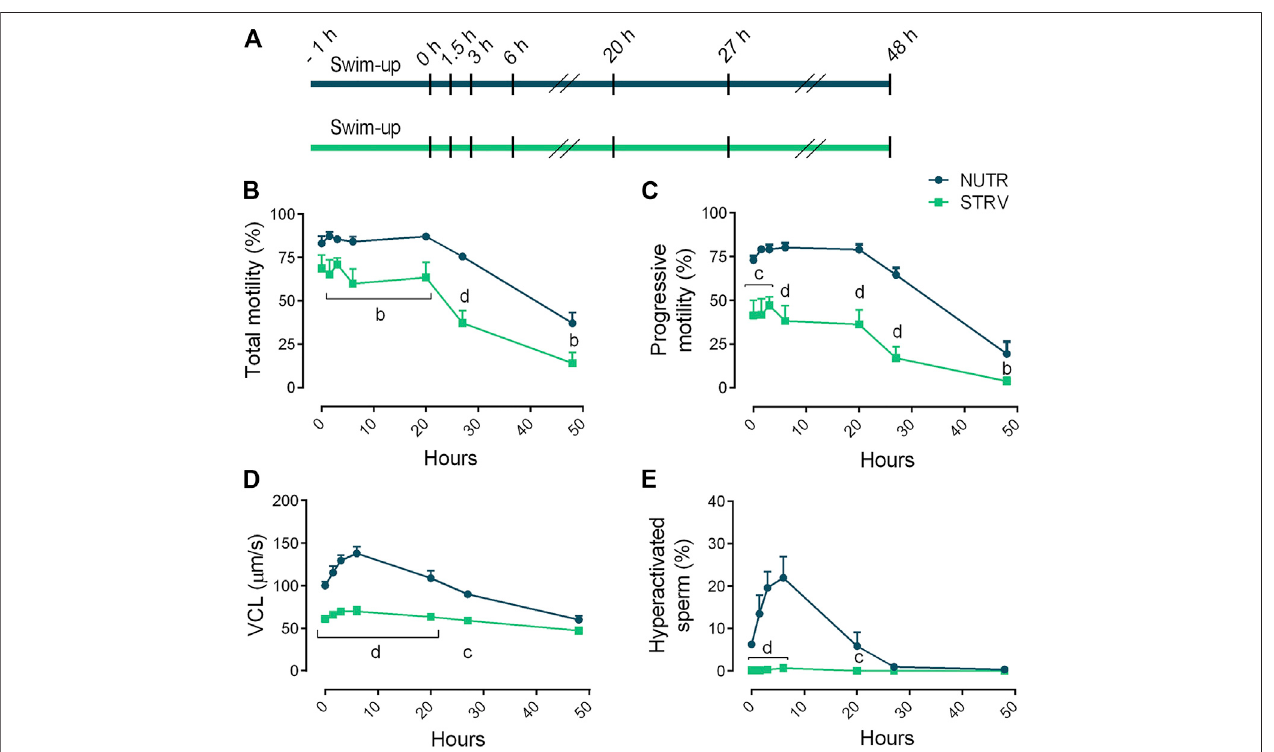
FIGURE 2 | Sperm motility after incubation for long periods of time in the presence or absence of exogenous nutrients. (A) Experimental design. Motile human sperm were selected and incubated in capacitating conditions in BWW containing glucose, lactate and pyruvate (NUTR) or in medium devoid of glucose, pyruvate and lactate (STRV). Motility parameters were recorded by CASA at 0, 1.5, 3, 6, 20, 27 and 48 h. (B) Total motility. (C) Progressive motility. (D) Curvilinear velocity (VCL). (E) Hyperactivated sperm. Results are expressed as mean ± SEM, n (cid:1) 5 experiments. b p < 0.01, c p < 0.001, d p < 0.0001 for STRV vs. NUTR at each corresponding time. Two-way ANOVA, and Bonferroni ’ s multiple comparison